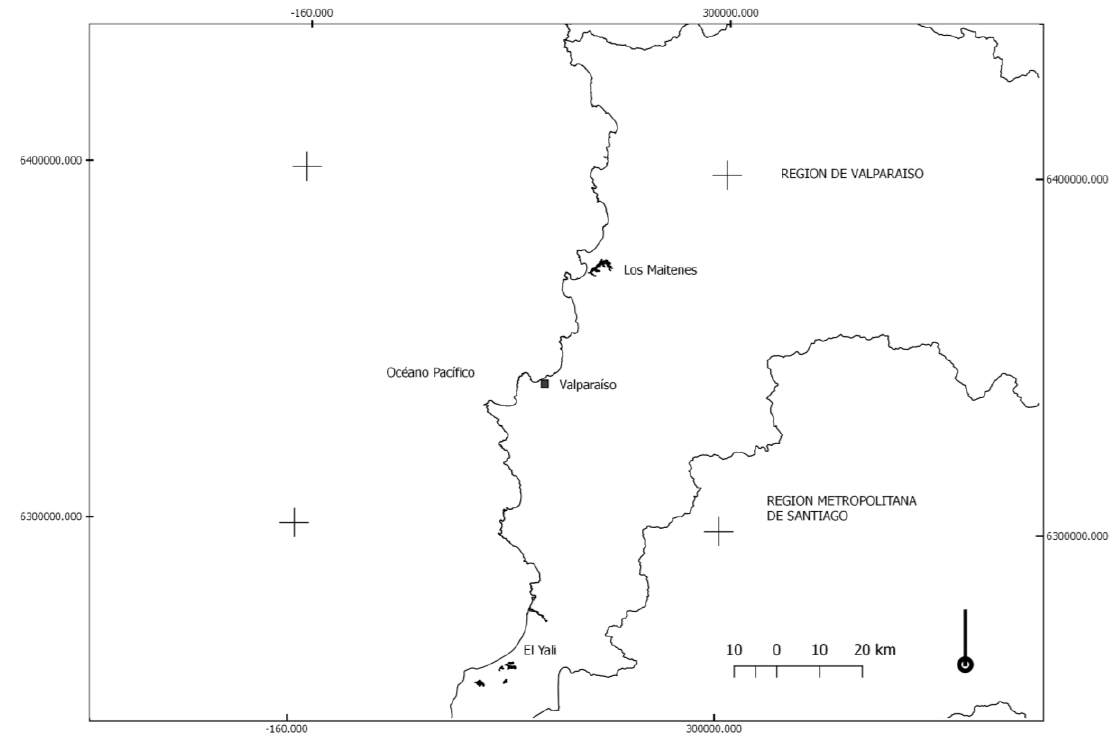
Figure 1. Central zone of Chile and coastal wetlands of interest in black. In the same line of the Pacific Ocean, at a distance of approximately 150 km.